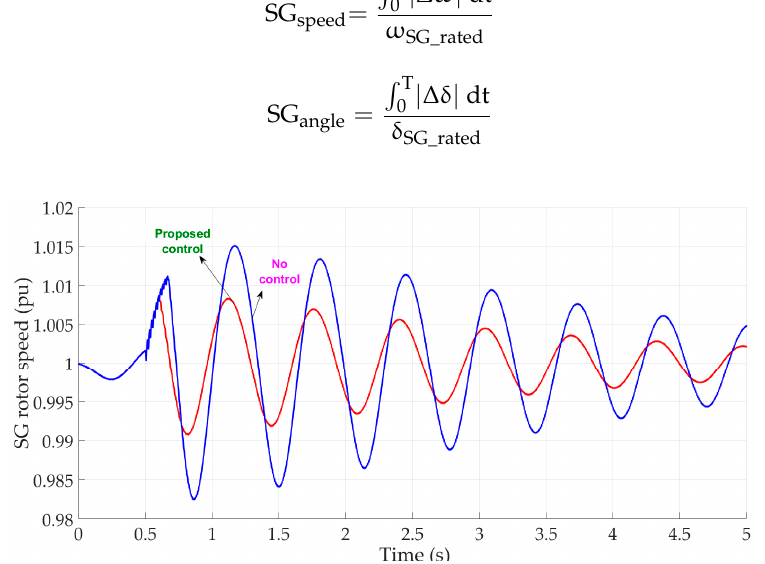
Figure 15. Synchronous generator (SG) rotor speed: no control and proposed control.